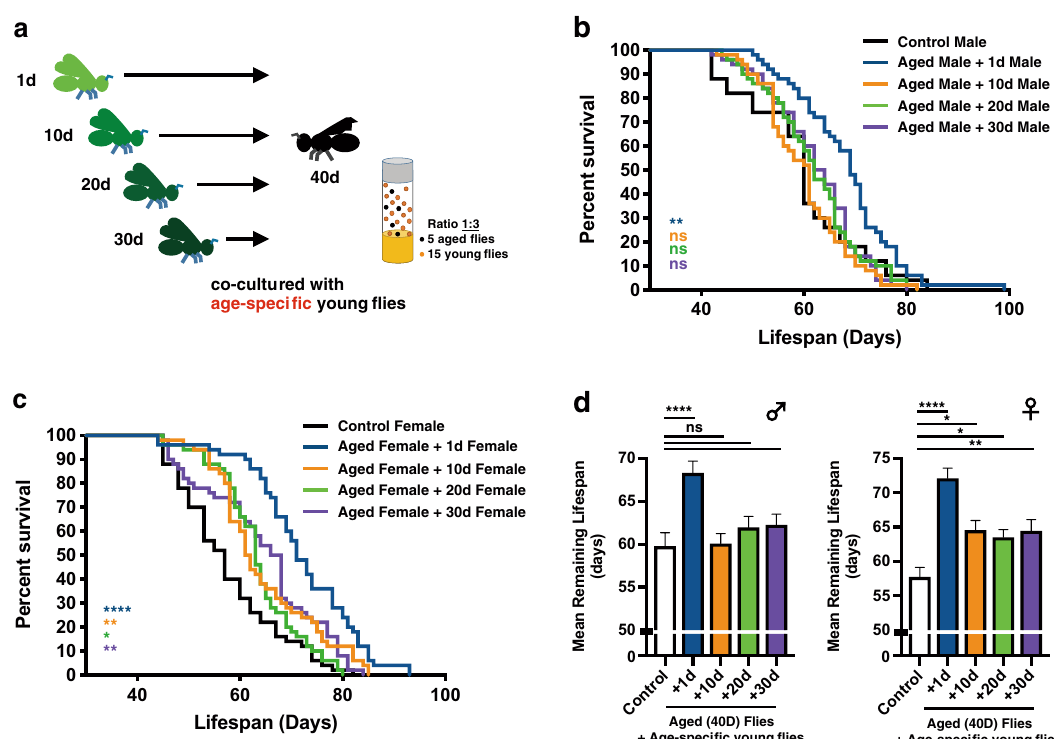
Fig. 3 Chronological ages of the co-housed young fl ies have different longevity-promoting capabilities. a An illustration of the experimental concept, in which aged fl ies were co-cultured with age-speci fi c young fl ies, was delineated. Brie fl y, 40d-old Canton-S aged fl ies were co-housed with 1d-, 10d-, 20d-, and 30d-old young fl ies respectively. Results were expressed as survival curves ( b ) for male fl ies, and ( c ) for female fl ies) and ( d ) means ± SEM. In all conditions, aged fl ies acquired stronger lifespan extension phenotypes when co-housed with younger fl ies. P values: ns > 0.1234; <0.0332*; <0.0021**; <0.0002***; <0.0001****. P values of the columns were annotated by the Kruskal – Wallis test and followed by Dunn ’ s multiple comparison test and survival curves were annotated by the Log-rank (Mantel-Cox) test. Sample size: n = 50 for each column; results were collected from 10 independent experimental